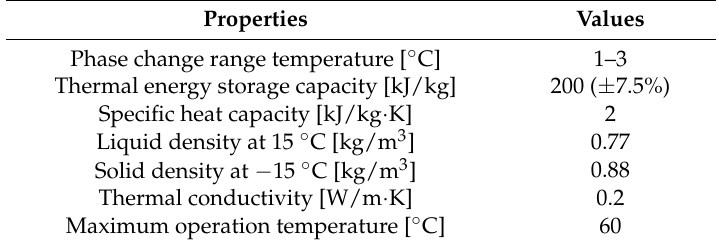
Table 1. Thermophysical properties of technical grade paraffin PCM (obtained from